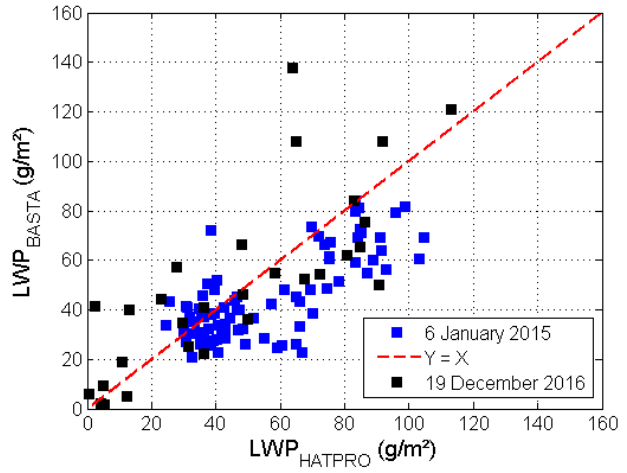
Figure 6. Liquid water path derived from Equation (7) versus liquid water path measured by HATPRO microwave radiometer (MWR).